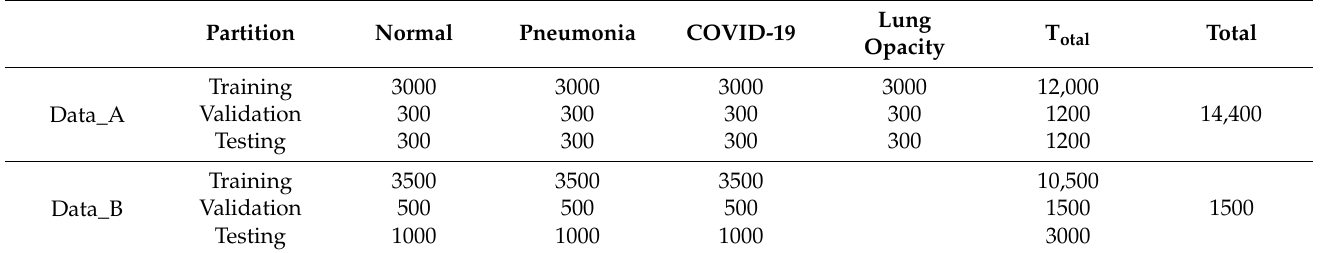
Table 2. Dataset distribution of the proposed method.